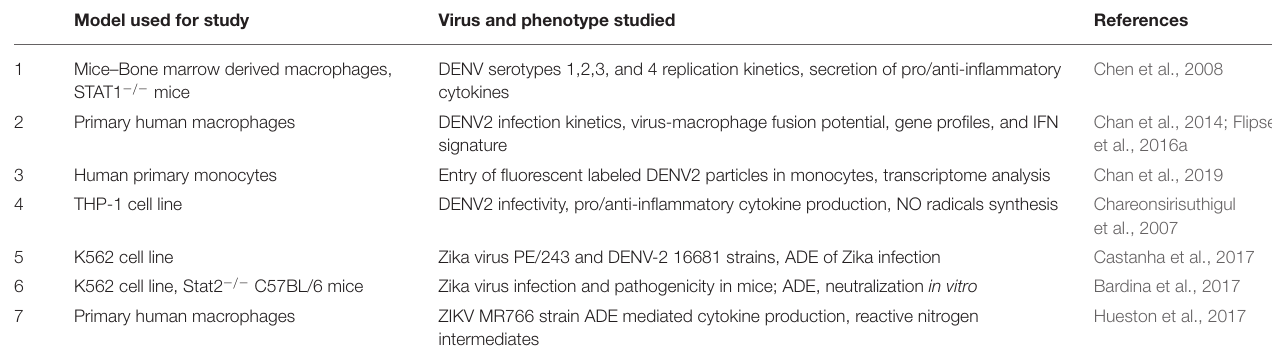
TABLE 1 | Summary of the animal models and phenotypes studied in select publications cited in this manuscript. Model used for